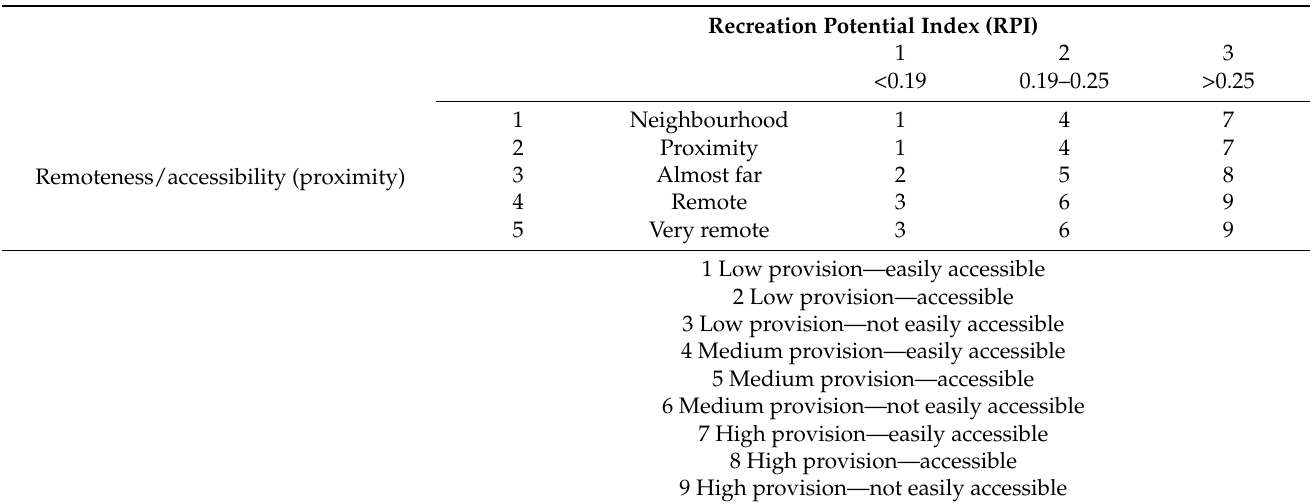
Table A2. Parameters for the recreational opportunity